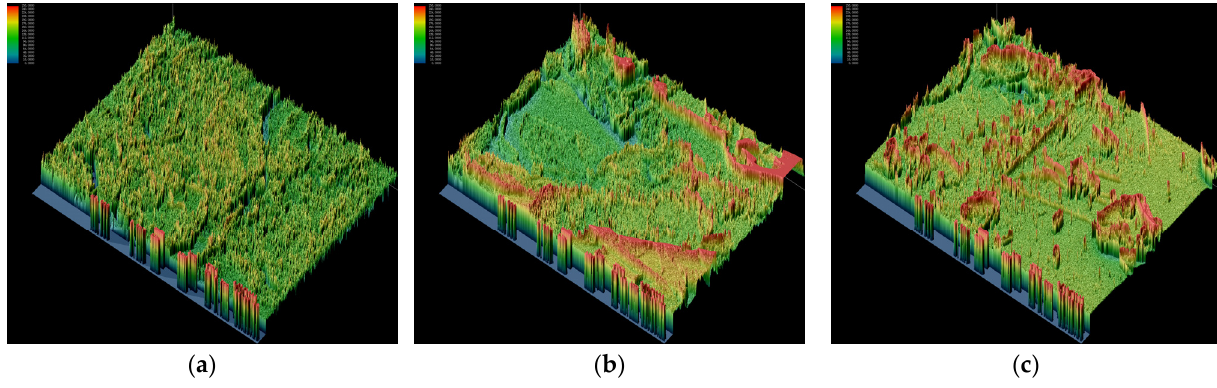
Figure 16. 3D image of mortar rubble ITZ. ( a ) SRB-1. ( b ) SRG-1. ( c ) SRL-1.